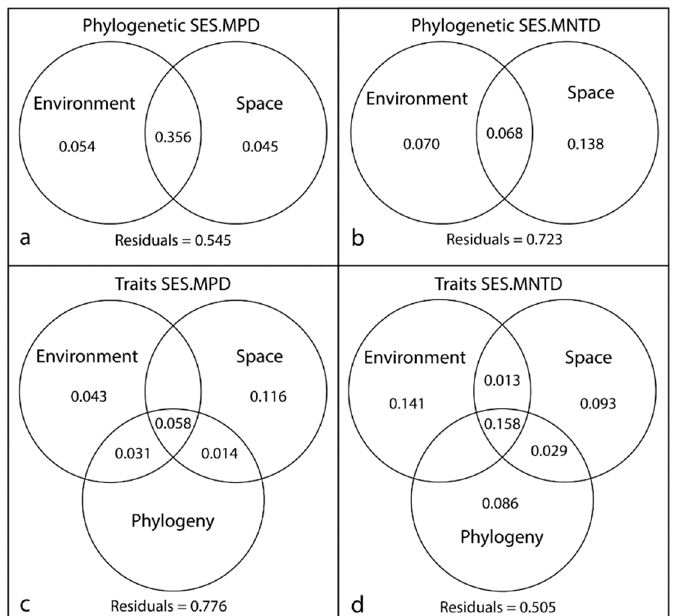
Figure 3. Variation partitioning of phylogenetic and functional trait structures: ( a ) interpretation rate of environmental factors and spatial factors to phylogenetic SES.MPD; ( b ) interpretation rate of environmental factors and spatial factors to phylogenetic SES.MNTD; ( c ) interpretation rate of environmental factors, spatial factors, and phylogenetic factors to trait SES.MPD; and ( d ) interpretation rate of environmental factors, spatial factors, and phylogenetic factors for trait SES.MNTD. The values represent the independent and common interpretation rate of each factor; null means no explanation and residuals represent the unexplained parts. Table 2. MRM of beta diversity of phylogenetic and functional traits.